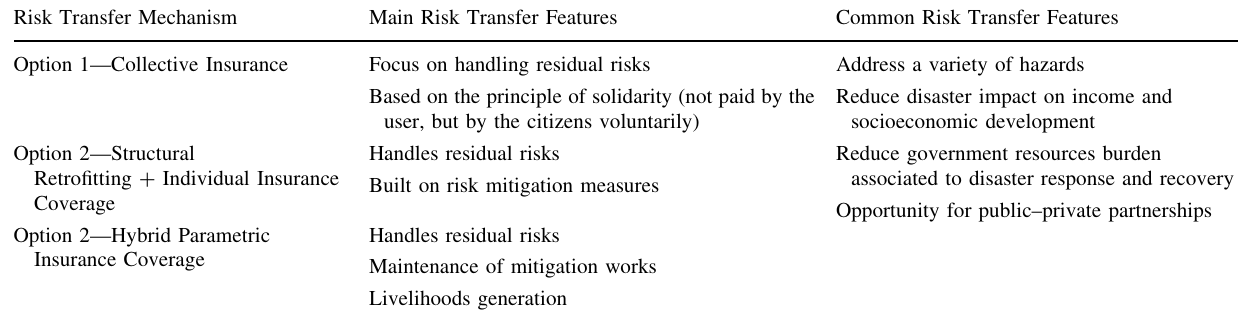
Table 7 Risk transfer options proposed Risk Transfer